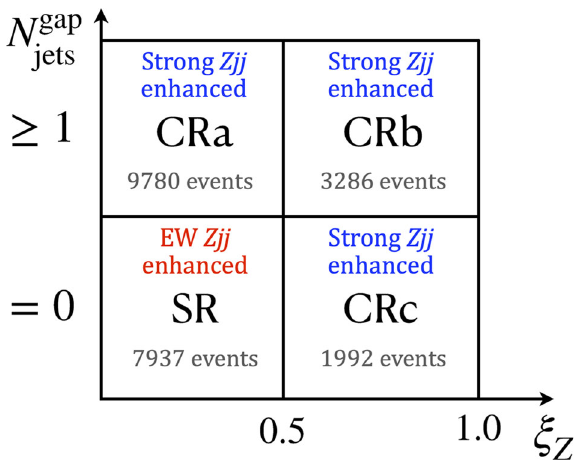
Fig. 4 Definition of the signal region (SR) and control regions (CRa, CRb, CRc) used in the extraction of the electroweak